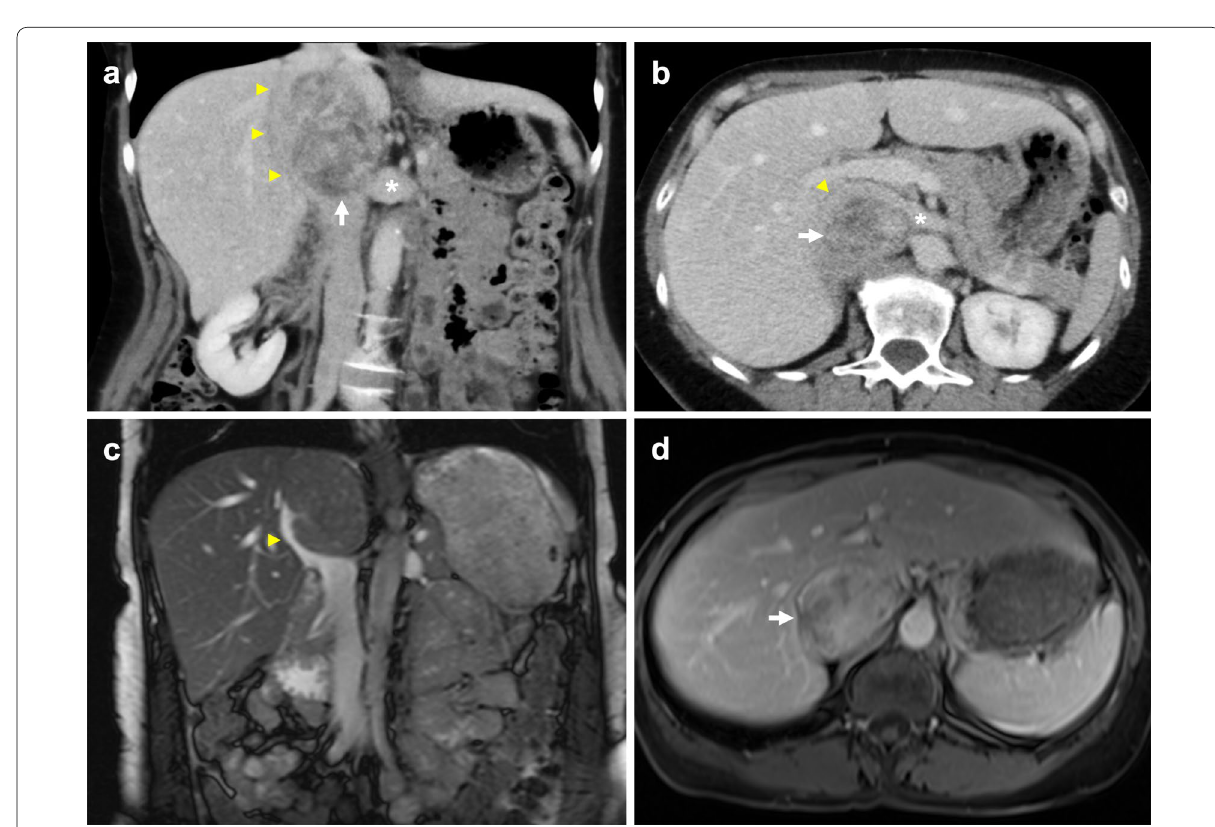
Fig. 13 IVC Leiomyosarcoma mistaken for adrenal lesion. a,b Coronal and axial contrast-enhanced CT demonstrate a heterogeneous mass (white arrows) displacing the left renal vein (asterisks) anteriorly and hepatic cava (yellow arrowheads) anterolaterally to the right. c T2-weighted axial MR image shows the effacement of the hepatic cava (arrowhead) without invasion of adjacent structures. d Contrast-enhanced T1-weighted fat-saturated axial image demonstrates heterogeneous enhancement of the tumour